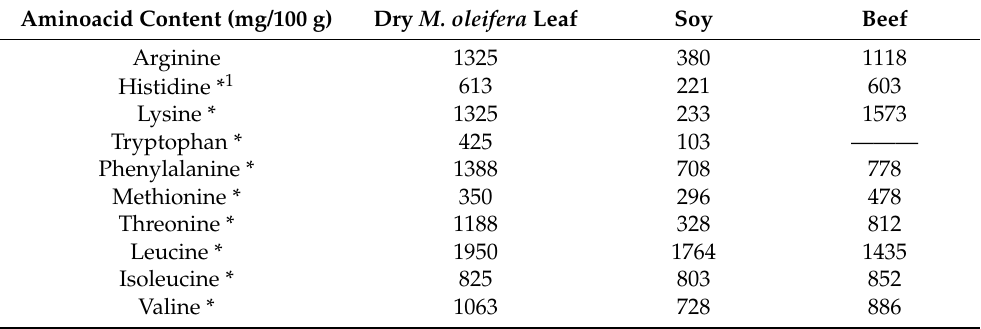
Table 2. Amino acid content in dried M. oleifera leaf, soybeans, and beef (Sources: [48,57]). Aminoacid Content (mg/100 g)